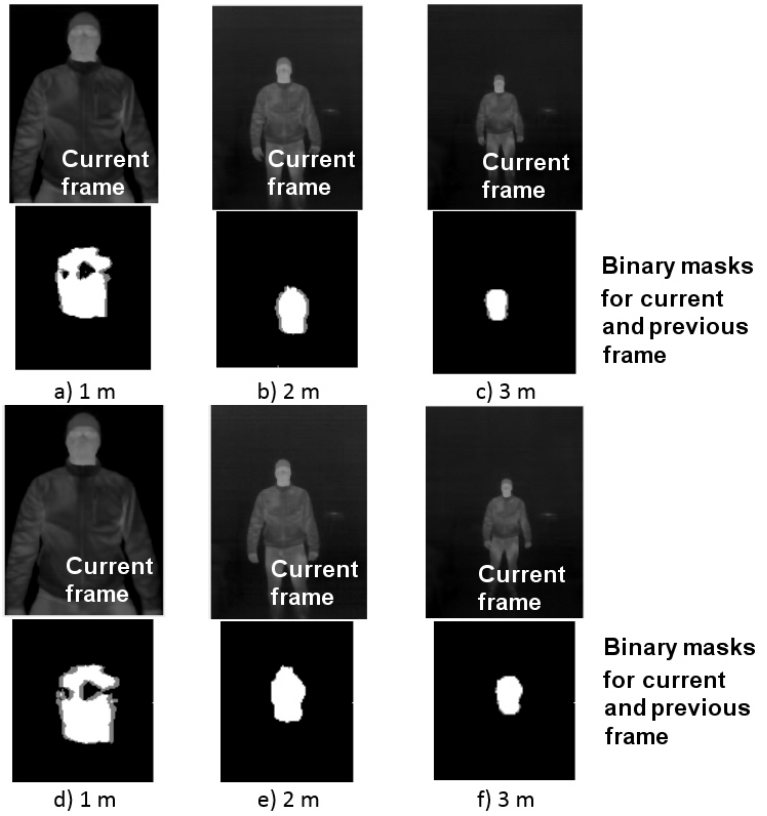
Figure 9. Images corresponding to measurement points Figure 10a–f from Sequence 1—Figure 7. Cases ( a – c ) correct classification, ( d – f ) incorrect